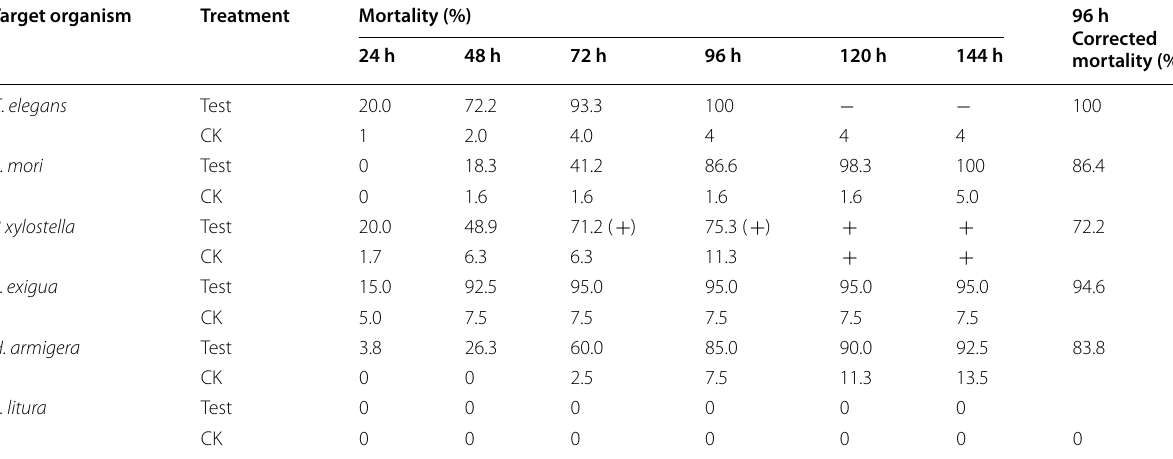
Note: “ ” and “ ” represent “pupation” and “termination of observation”, respectively + −